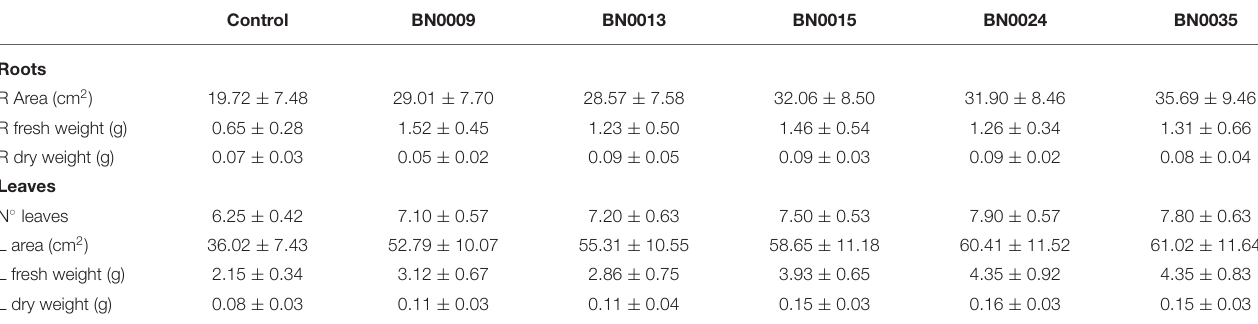
TABLE 3 | Growth parameters from the lettuce pot experiment with seed inoculation of the five selected strains BN0009, BN0013, BN0015, BN0024, and BN0035. Control BN0009 BN0013 BN0015 BN0024